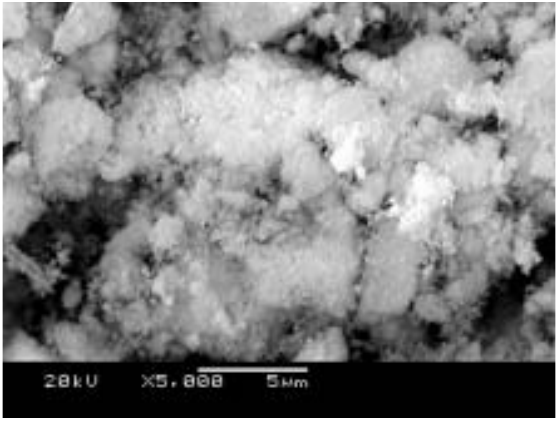
Fig. 11 Surface-coated photocatalyst